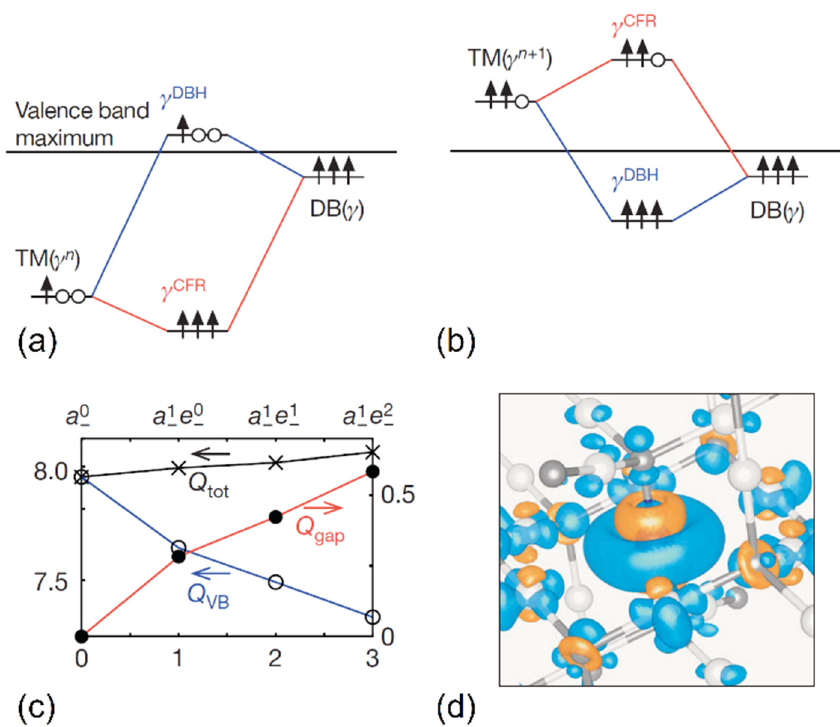
Figure 2. Energy level scheme examples for a transition metal compound with ( a ) charge q and ( b ) charge q − 1 around the valence band maximum of the bulk. Upward arrows indicate occupied states of the TM, the ligand dangling bonds (DB), the TM-assigned crystal field resonance (CFR) hybrid orbitals, and the ligand-assigned hybrid (DBH) levels; empty circles indicate the corresponding unoccupied states. TM and DB states are chosen from the same irreducible representation γ . The integrated charges Q around a Co dopant in Cu 2 O are plotted against the total charge of the simulation cell in ( c ) and decomposed into low-lying valence band (VB) and high-energy gap state contributions (in insulators). The corresponding charge density difference around Co between the neutral and the +1 charged system is shown in ( d ), with positive density differences represented by blue, negative ones by orange isosurfaces (isovalue − 0.003 |e| Å − 3 ). Adapted with permission from Springer Nature Customer Service Centre GmbH: Springer Nature [26], Copyright